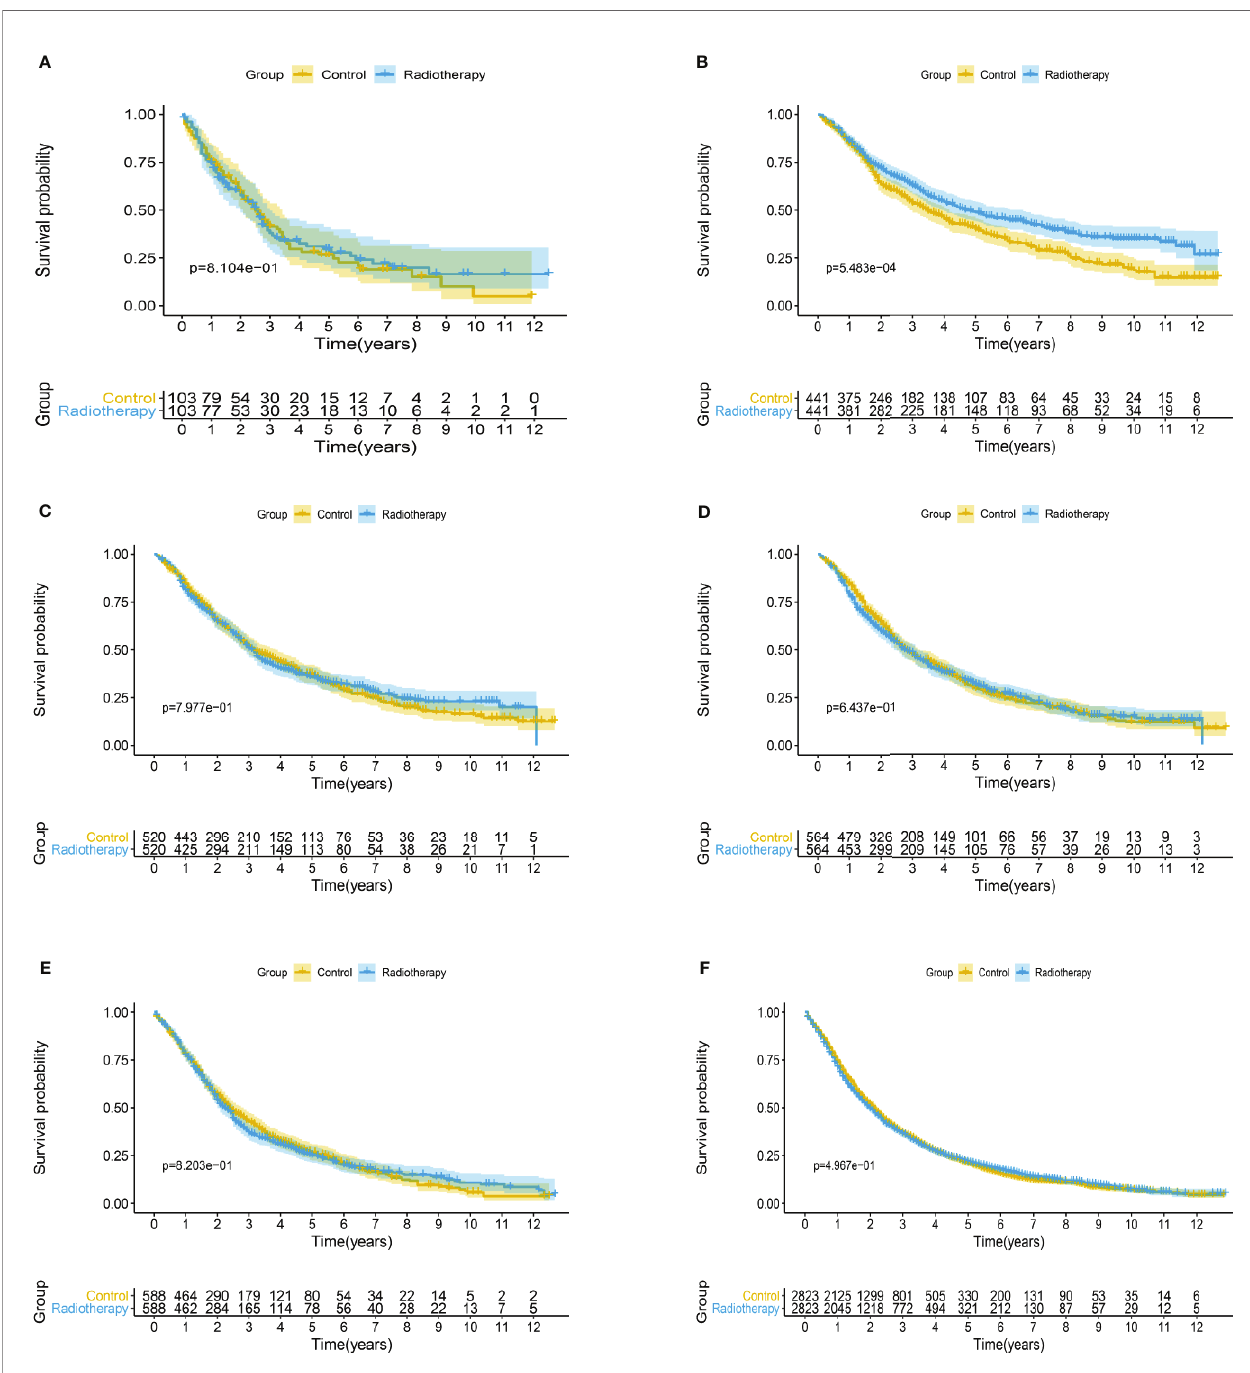
FIGURE 2 | Kaplan-Meier survival analysis of overall survival in (A) PSA <4 ng/mL, (B) PSA 4.1 – 10 ng/mL, (C) PSA 10.1 – 20 ng/mL, (D) PSA 20.1 – 40 ng/mL, (E) PSA 40.1 – 80 ng/mL, and (F) PSA >80.1 ng/mL